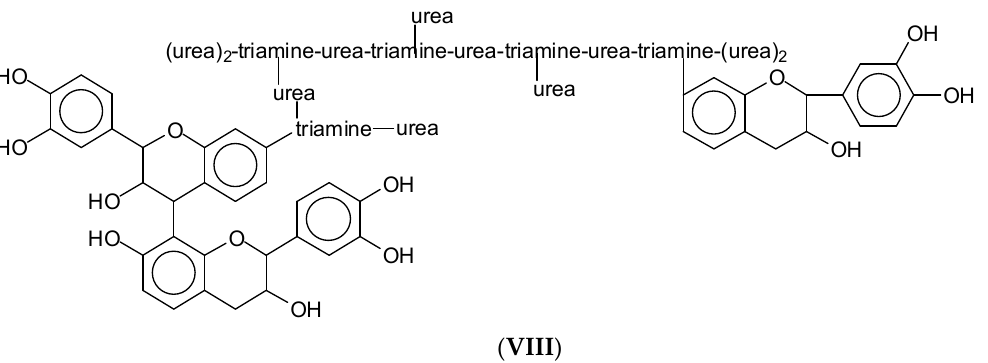
Figure 10. An example of a detected structure with three flavonoid units, one of which a flavonoid dimer linked to a triamine-urea hyperbrached network part.